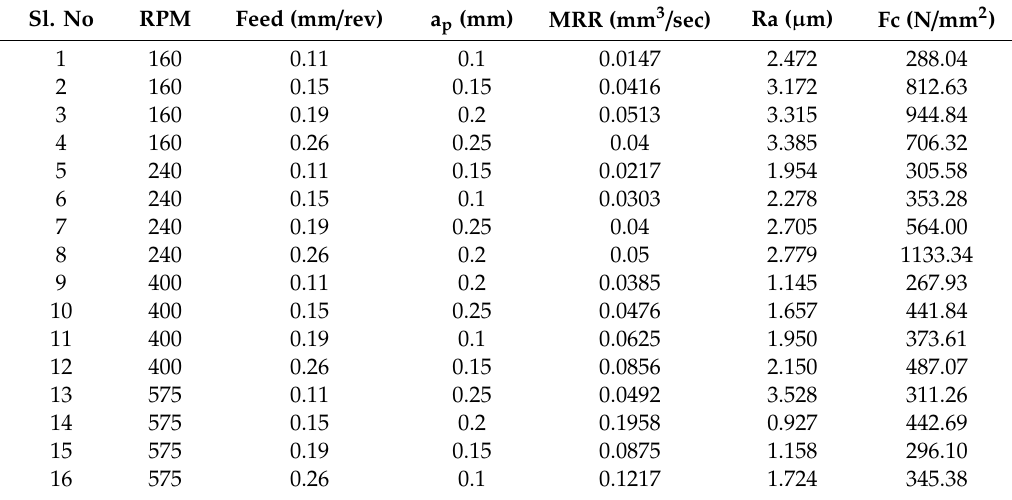
Table 3. Experimental